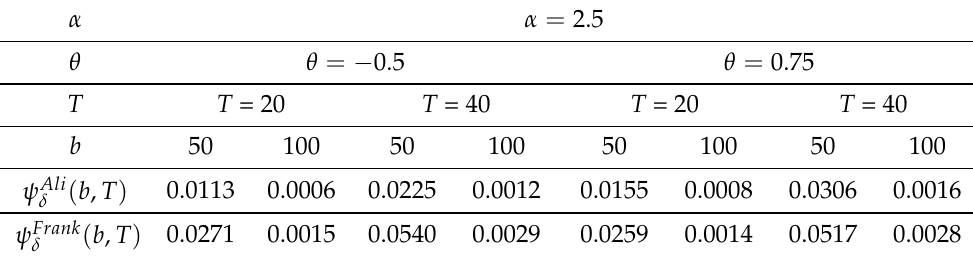
Table 2. Asymptotic ruin probability for mixed homogeneous Poisson risk model with interest rate.